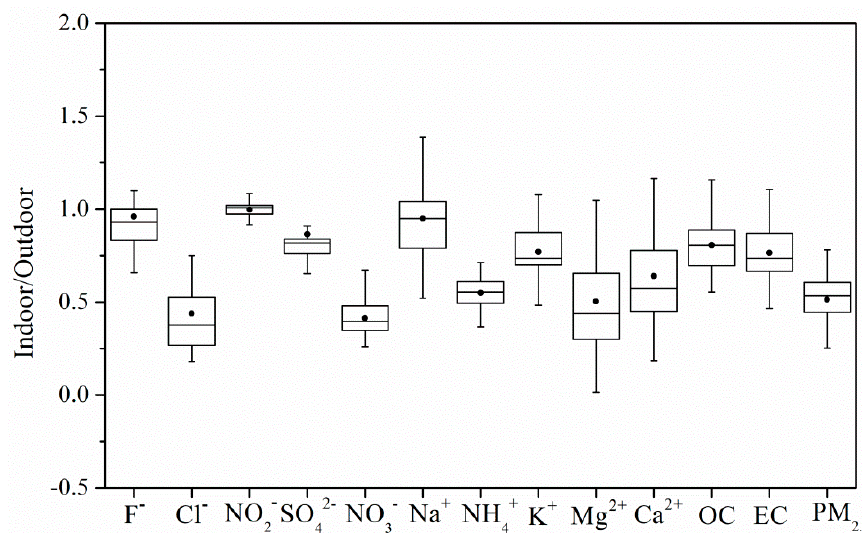
Figure 4. Indoor / outdoor ratios (I / O ratios) of PM 2.5 and its chemical components (Boxes range: 25% Figure 4. Indoor/outdoor ratios (I/O ratios) of PM 2.5 and its chemical components (Boxes range: 25% and 75%; Points: median; Whiskers: 1.5 times the interquartile range and 75%; Points: median; Whiskers: 1.5 times the interquartile range away).